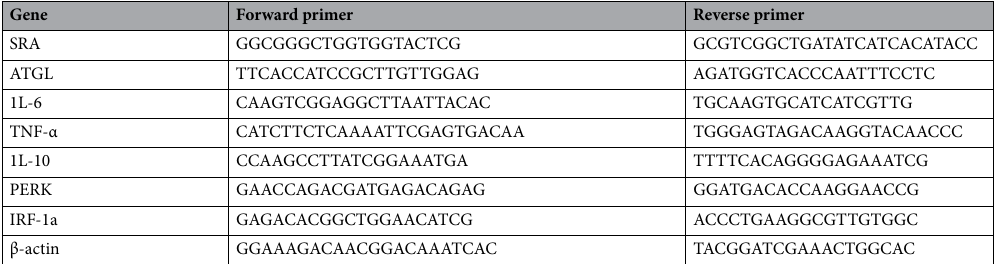
Table 2. Primers for mRNA expression analysis in RT-qPCR. SRA, long non-coding RNA steroid receptor RNA activator; ATGL, adipose triglyceride lipase; 1L-6, interleukin 6; TNF-α, tumor necrosis factor; 1L-10, interleukin 10; PERK, protein kinase R-like endoplasmic reticulum kinase; IRE-1α, inositol-requiring enzyme 1; β-actin,